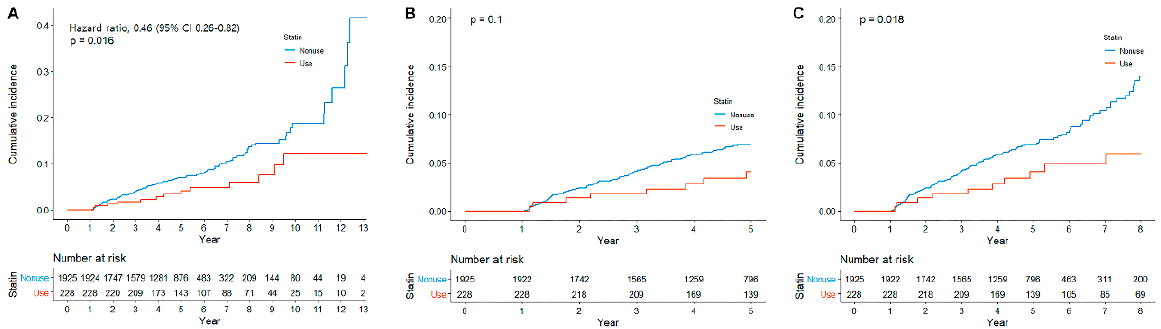
Figure 1. Cumulative incidence of metachronous gastric cancer according to statin use, (A) overall, (B) until 5 years, and (C) until 8 years.